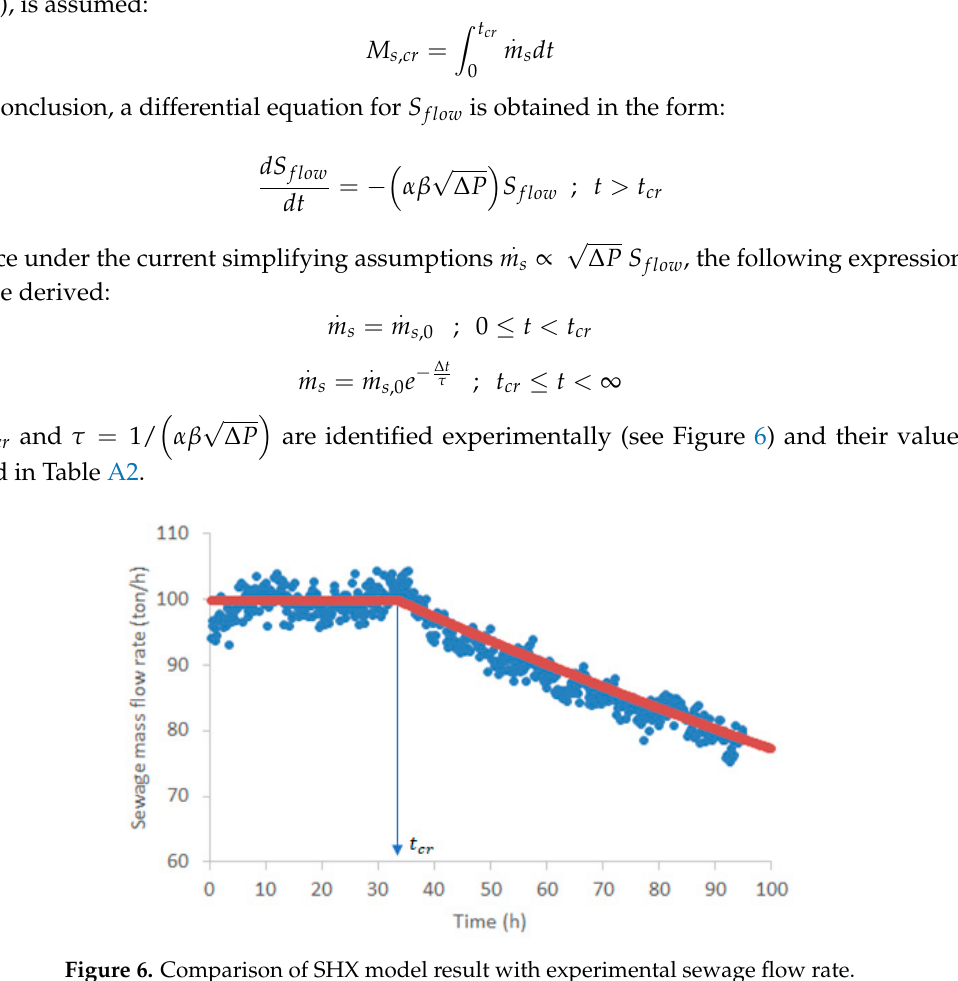
Figure 6. Comparison of SHX model result with experimental sewage flow rate.